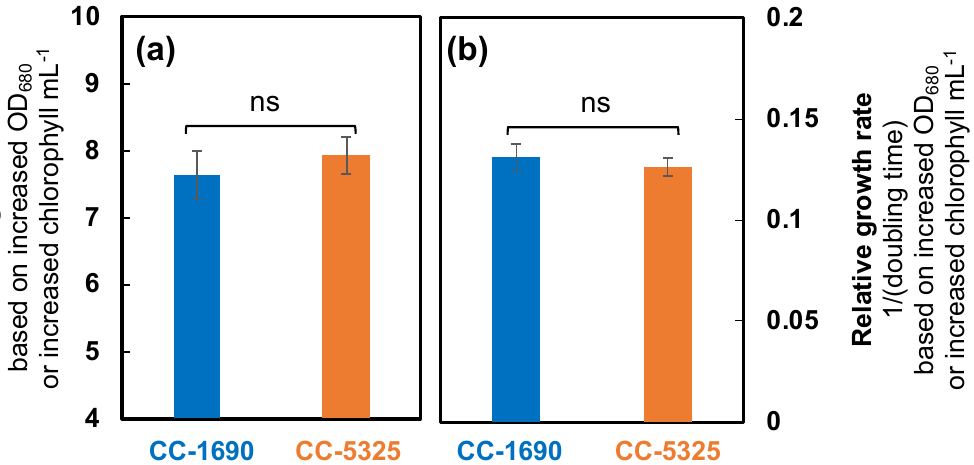
Figure 2. CC-1690 and CC-5325 had comparable growth rates under mixotrophic conditions in photobioreactors (PBRs). Chlamydomonas cells were grown in turbidostatically controlled PBRs in Tris-acetate phosphate (TAP) medium at 25 ◦ C with a light intensity of 100 µ mol photons m − 2 s − 1 and constantly bubbling of air. Doubling time ( a ) and relative growth rates (( b ), inverse of dou- bling time) were calculated based on the exponential increase of OD 680 , which is proportional to total chlorophyll content in unit of µ g chlorophyll mL − 1 and cell density at 25 ◦ C. Mean ± SE, N = 3 biological replicates. Statistical analyses were performed using a two-tailed t -test assuming unequal variance by comparing the two strains. Not significant,